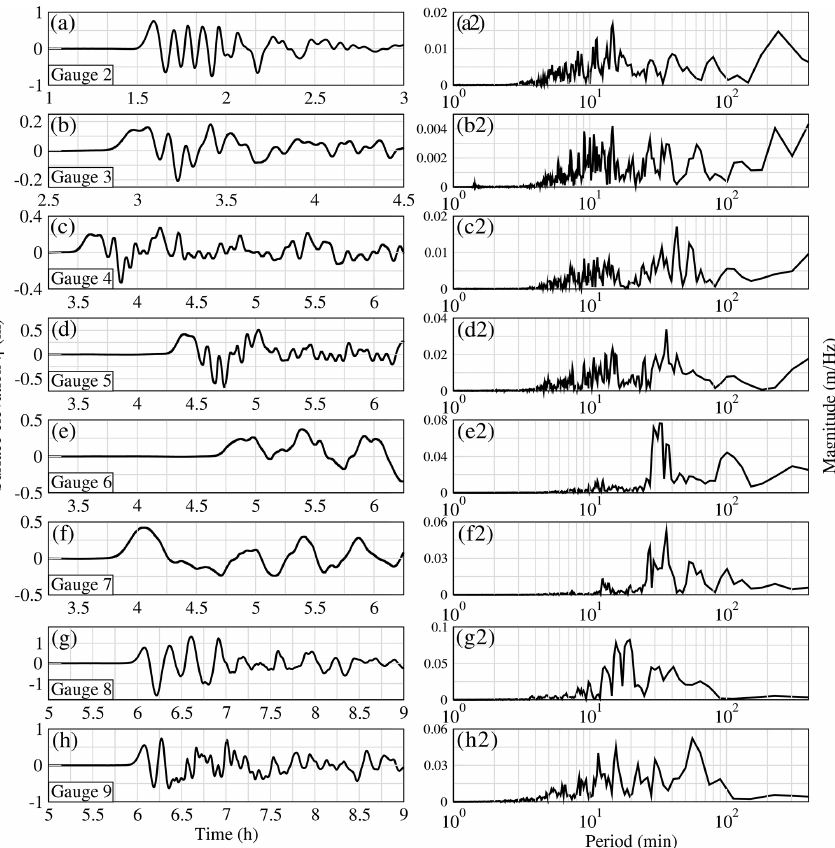
Figure 17. Surface elevations (m) (left column) and Fourier transforms (right column) for the 80km 3 scenario at Gauge 2 in southern Portugal ( a and a2 ), Gauge 3 in the abyssal plain of the Bay of Biscay ( b and b2 ), Gauge 4 on the continental shelf of the Bay of Biscay ( c and c2 ), Gauge 5 in southern Brittany ( d and d2 ), Gauge 6 in the Gironde estuary ( e and e2 ), Gauge 7 in Saint-Jean-de-Luz ( f and f2 ), and gauges 8 and 9, respectively, north ( g and g2 ) and south ( h and h2 ) of Guadeloupe, computed by FUNWAVE-TVD. The time takes into account the first 20min of the slide and tsunami